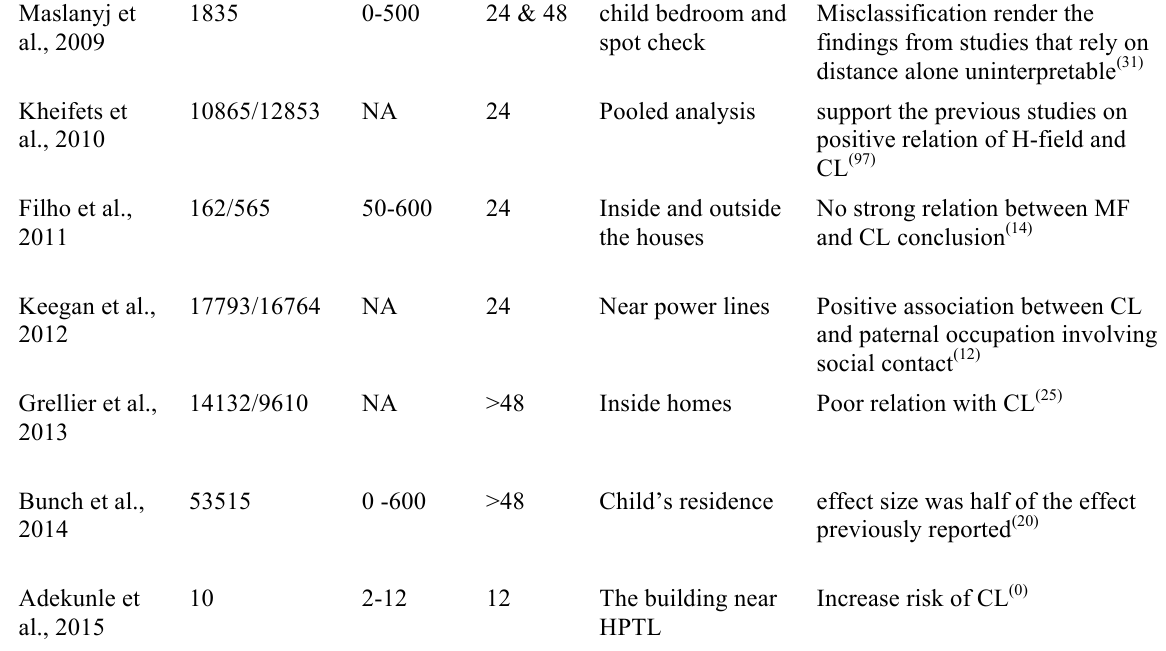
Table 1: Showing the association of extremely low-frequency electromagnetic field and childhood leukemia from different